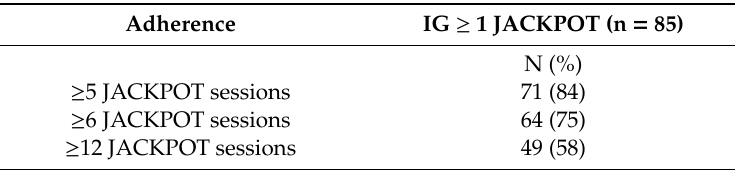
Table 2. Attendance for the JACKPOT programme.